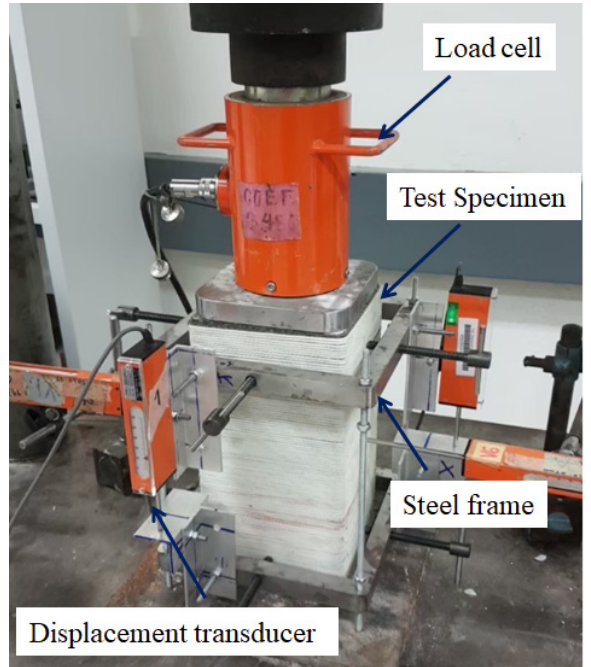
Figure 5. Typical loading setup.